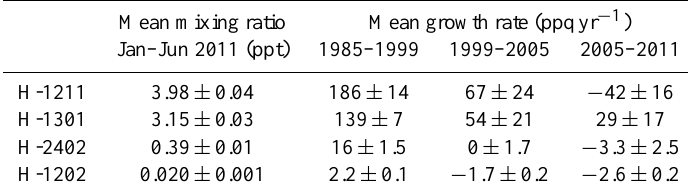
Table 1. Mean mixing ratios of the halons at Cape Grim for January to June 2011, and mean growth rates for the periods